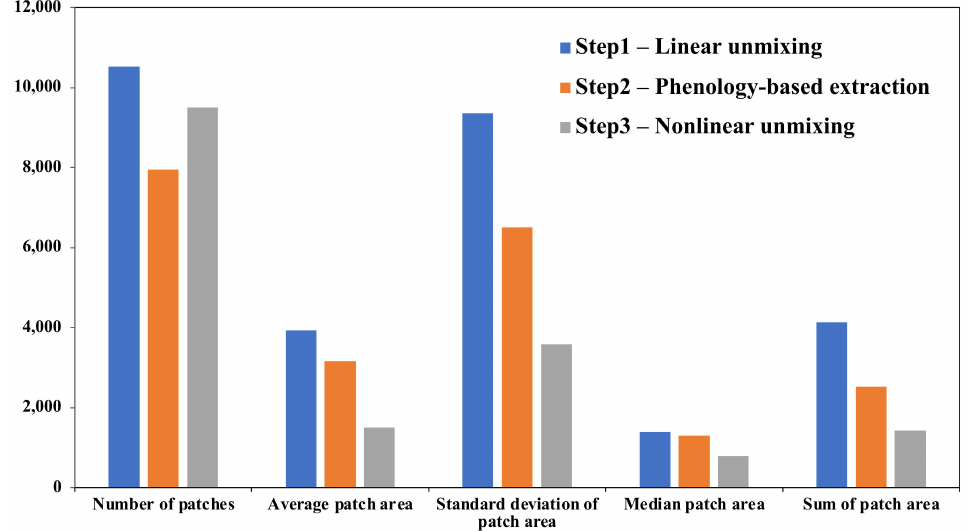
Figure 7. Statistics of kudzu patches identified in each